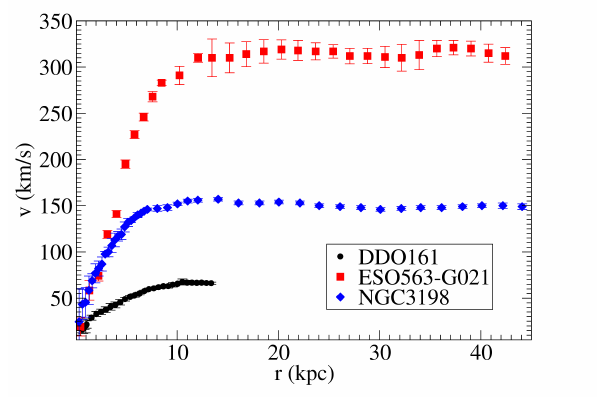
Figure 1. Galactic rotation curves show a flat (distance-independent) rotation velocity at large distances to the galactic center (data sample from Reference [2], SPARC